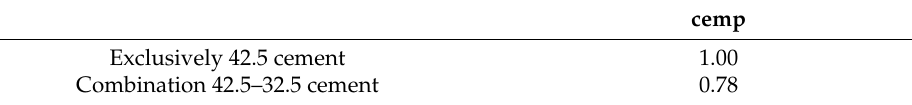
Table 24. Cement parameter cemp.